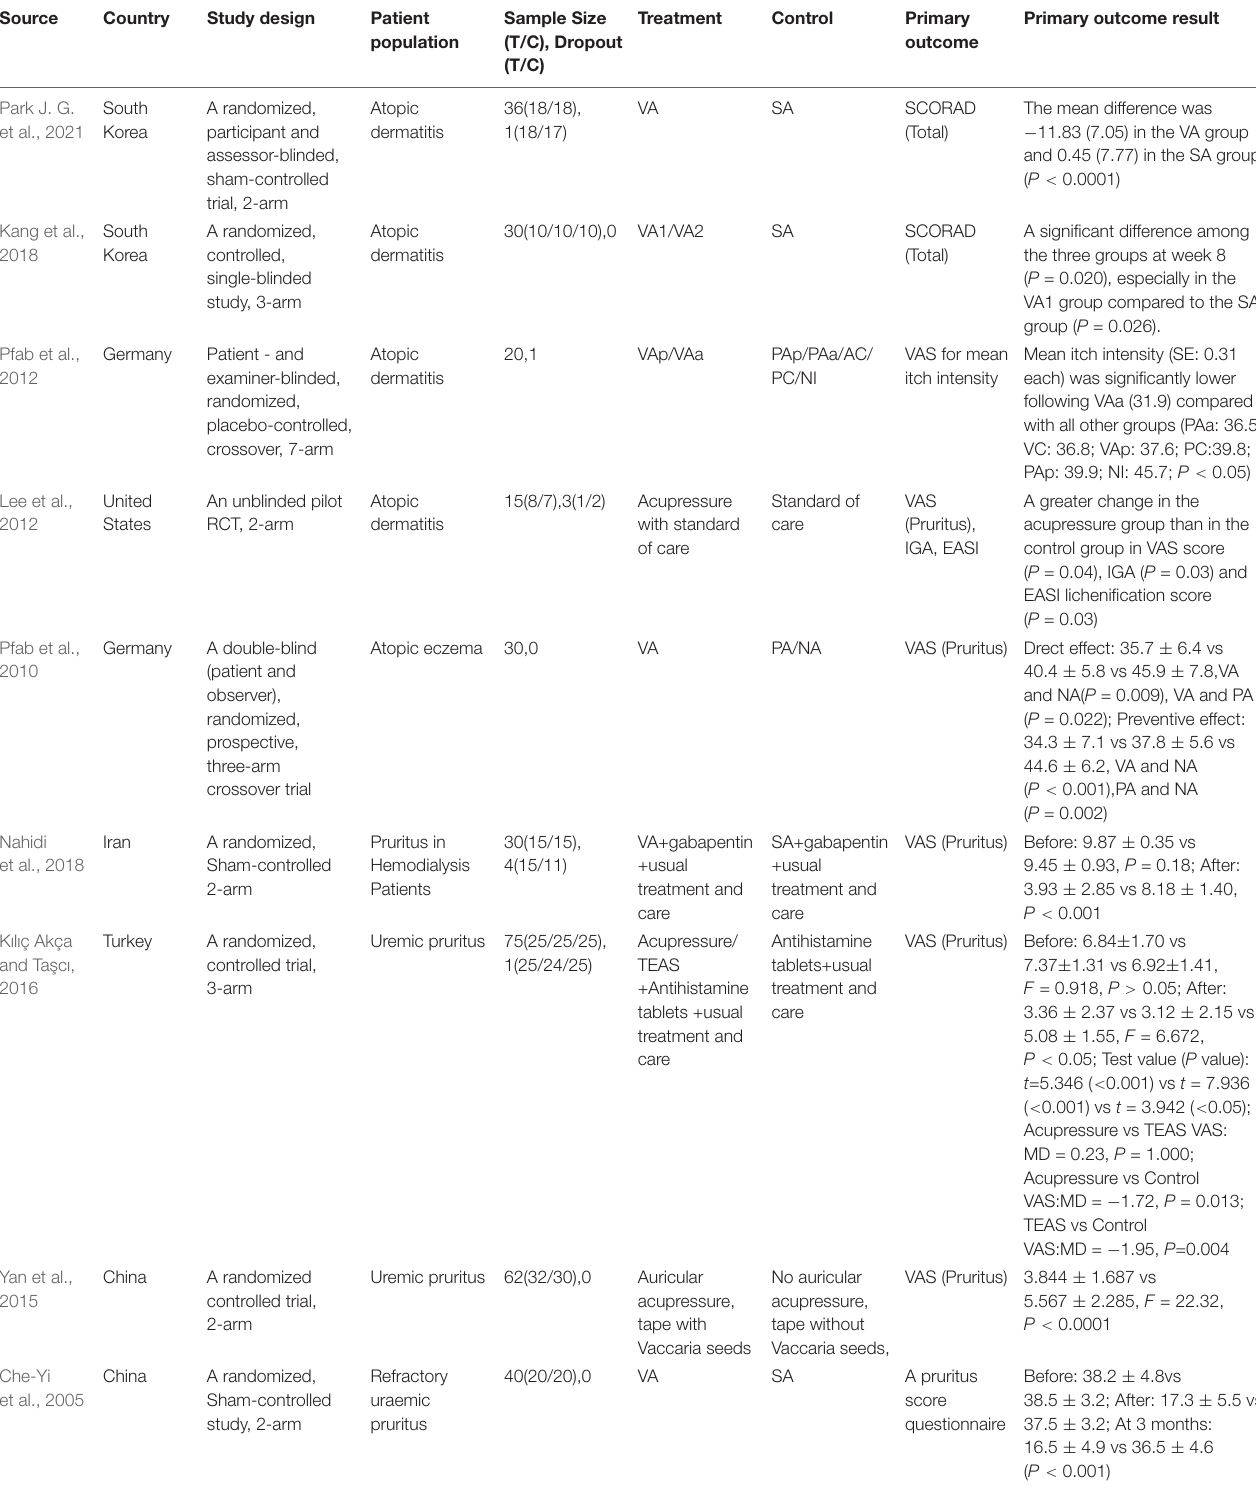
TABLE 1 | Effects of acupuncture treatment for